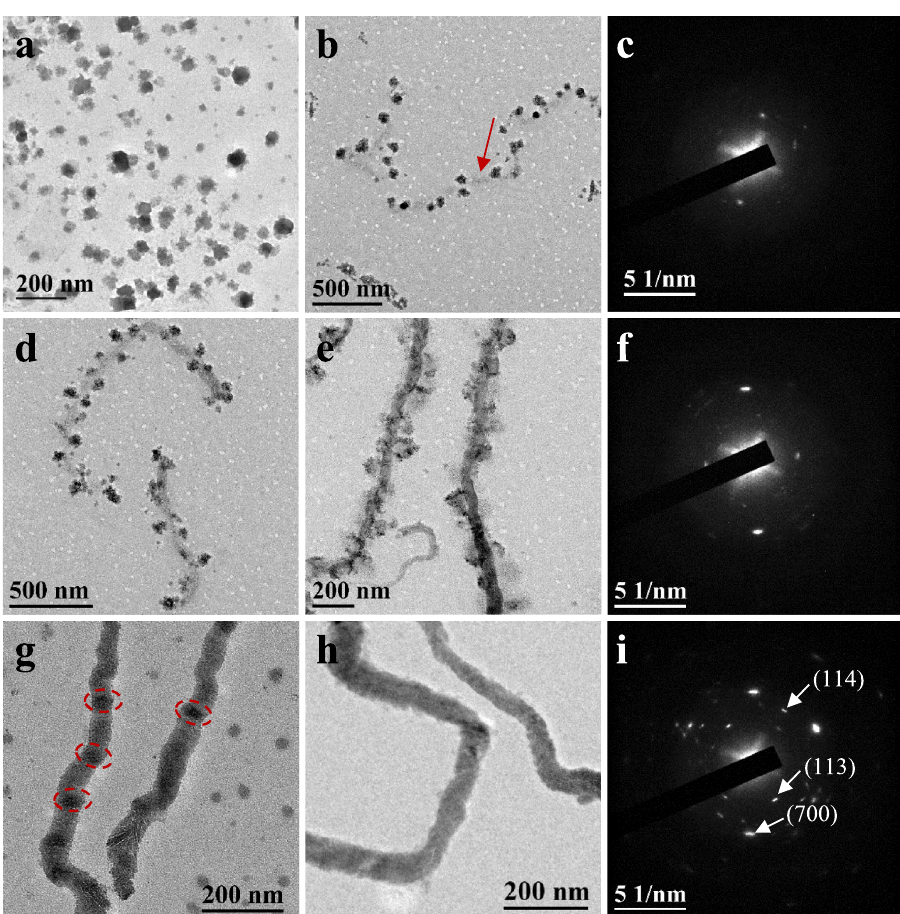
Fig. 2 Formation of semicrystalline cylinders via CD-FIPA of spherical micelles. a Incubated for 15 min, b 30 min, and c corresponding SAED pattern; d 60 min, e 90 min, and f corresponding SAED pattern; g 3 h, h 6 h, and i corresponding SAED pattern.